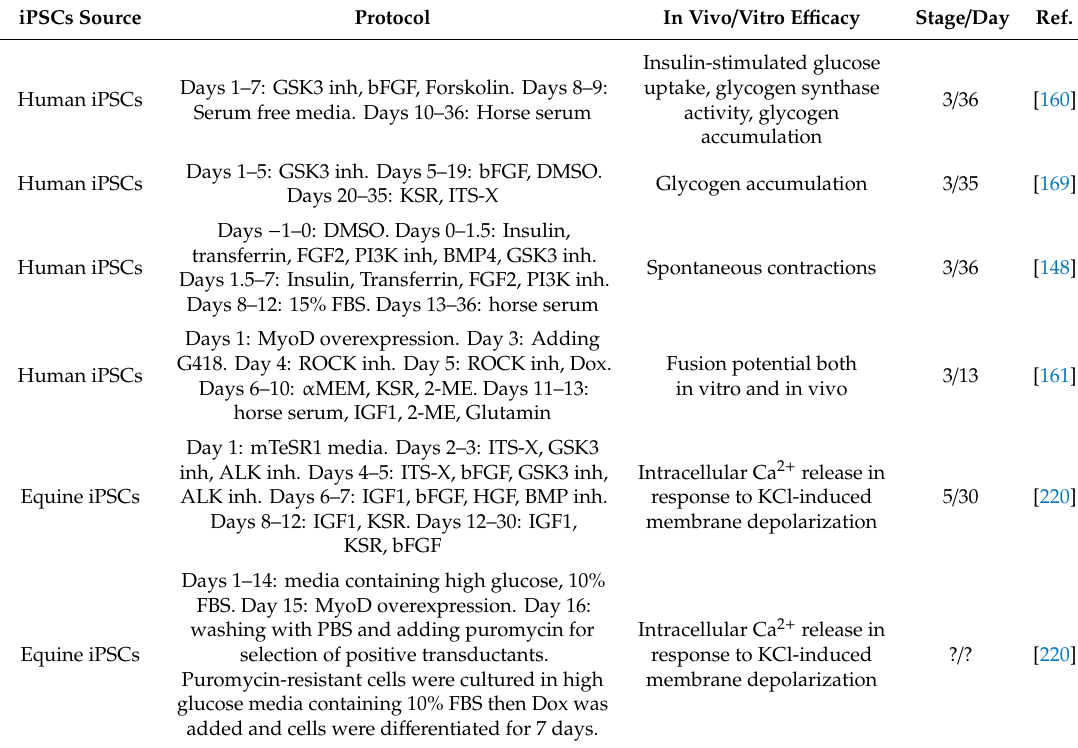
Table 4. Overview of protocols used for di ff erentiation of myotubes from various sources of iPSCs. iPSCs